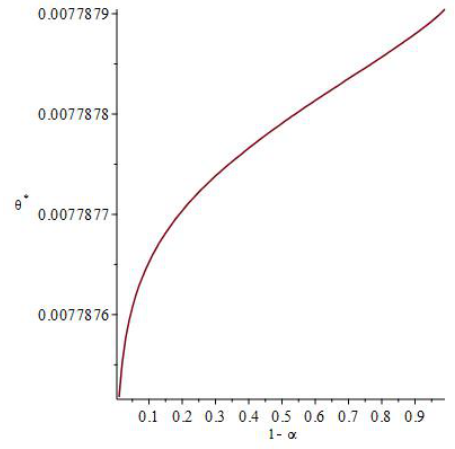
Figure 1. Optimal θ ∗ values as a function of the tolerance level 1 − α